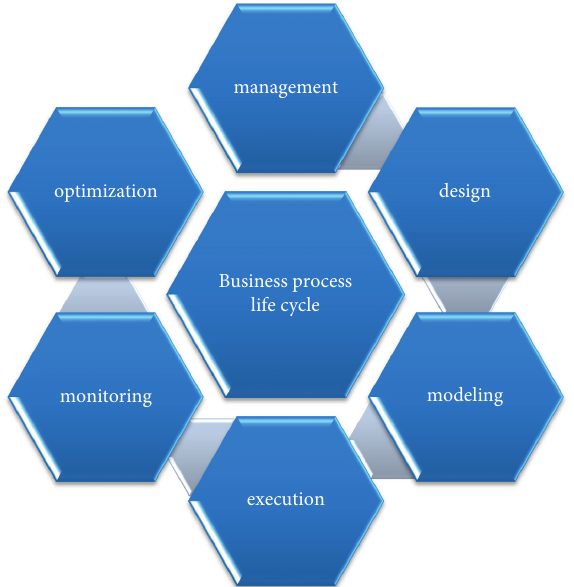
Figure 7: The general trend of stochastic capital structure in in- frastructure financing.